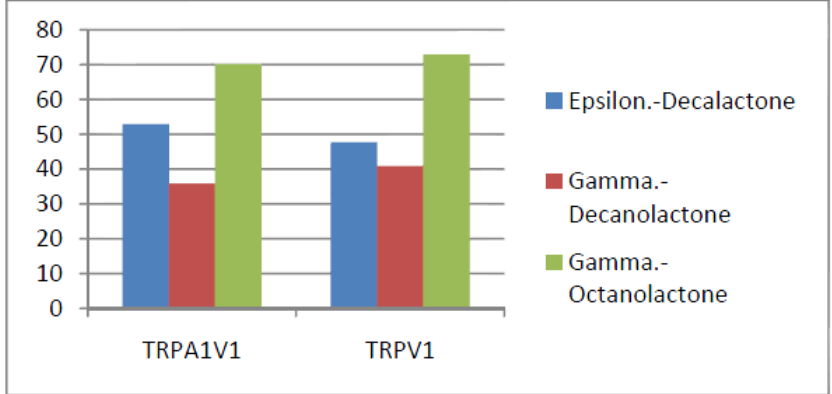
Figure 6. Examples of compounds that activate TRPV1 = TRPA1V1, but not